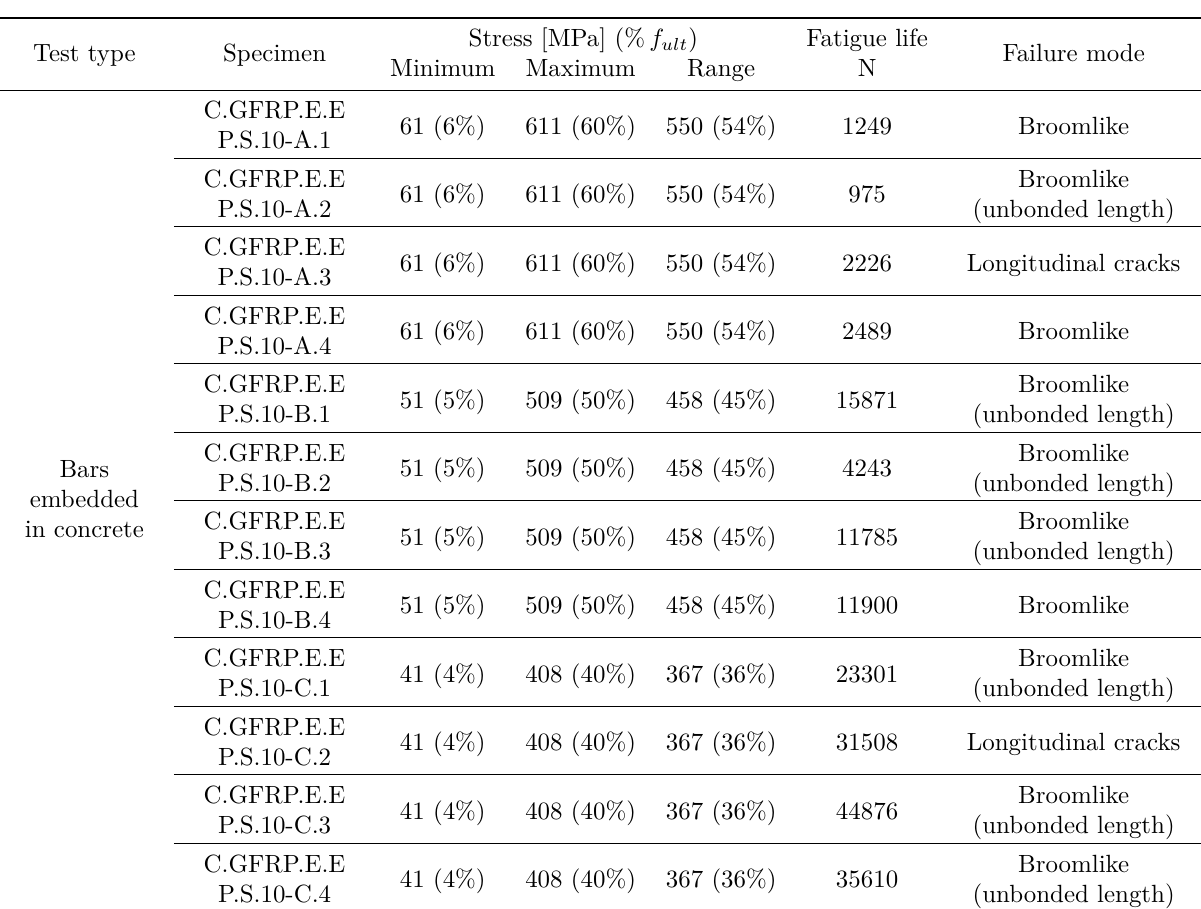
Table 4. Tested specimens - fatigue life.